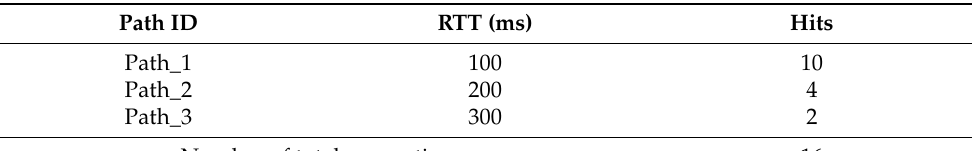
Table 1. Path management table.